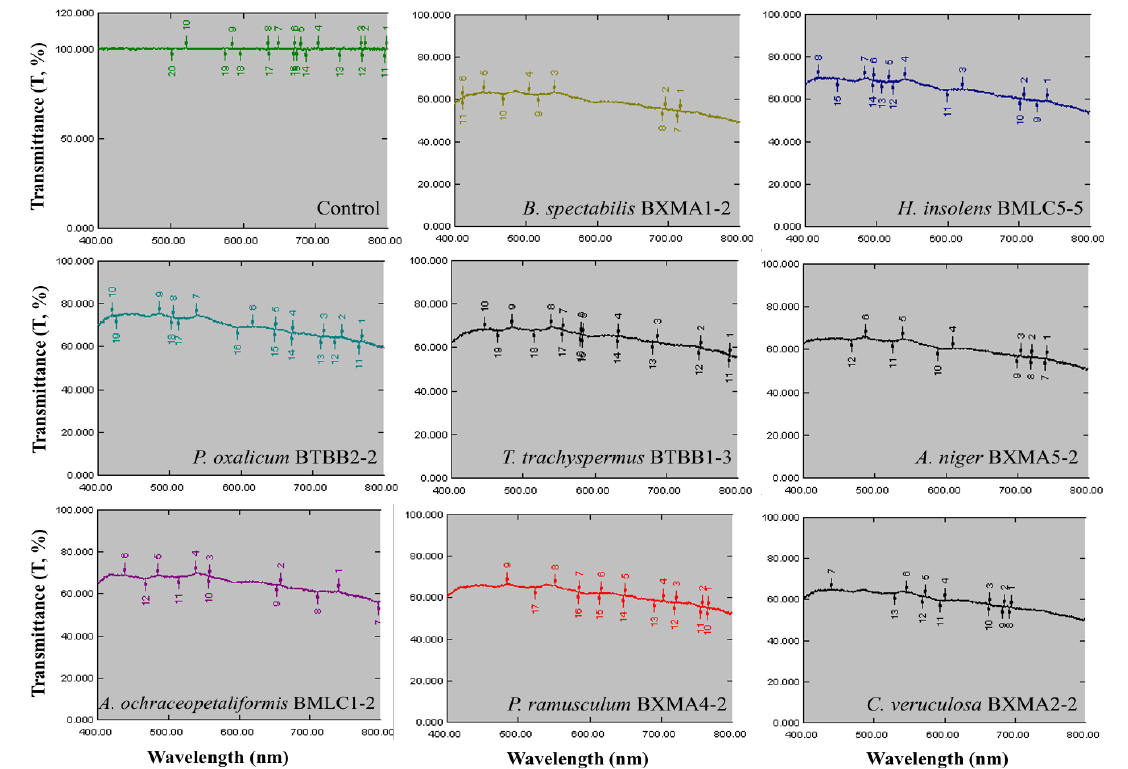
Figure 4. The effect of fungal growth on light transmission through fungus-inoculated glass samples in the visible light spectrum.